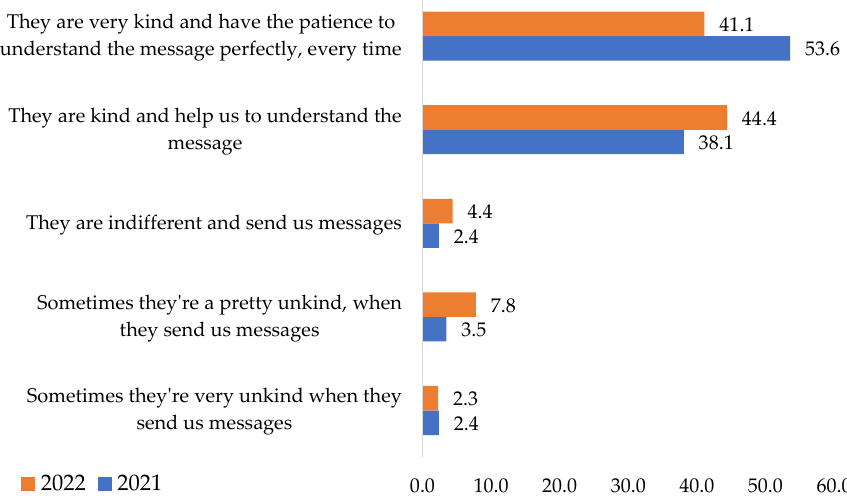
Figure 10. Leaders and staff communicating attitude: Data from field quizzes, 2021, 2022.